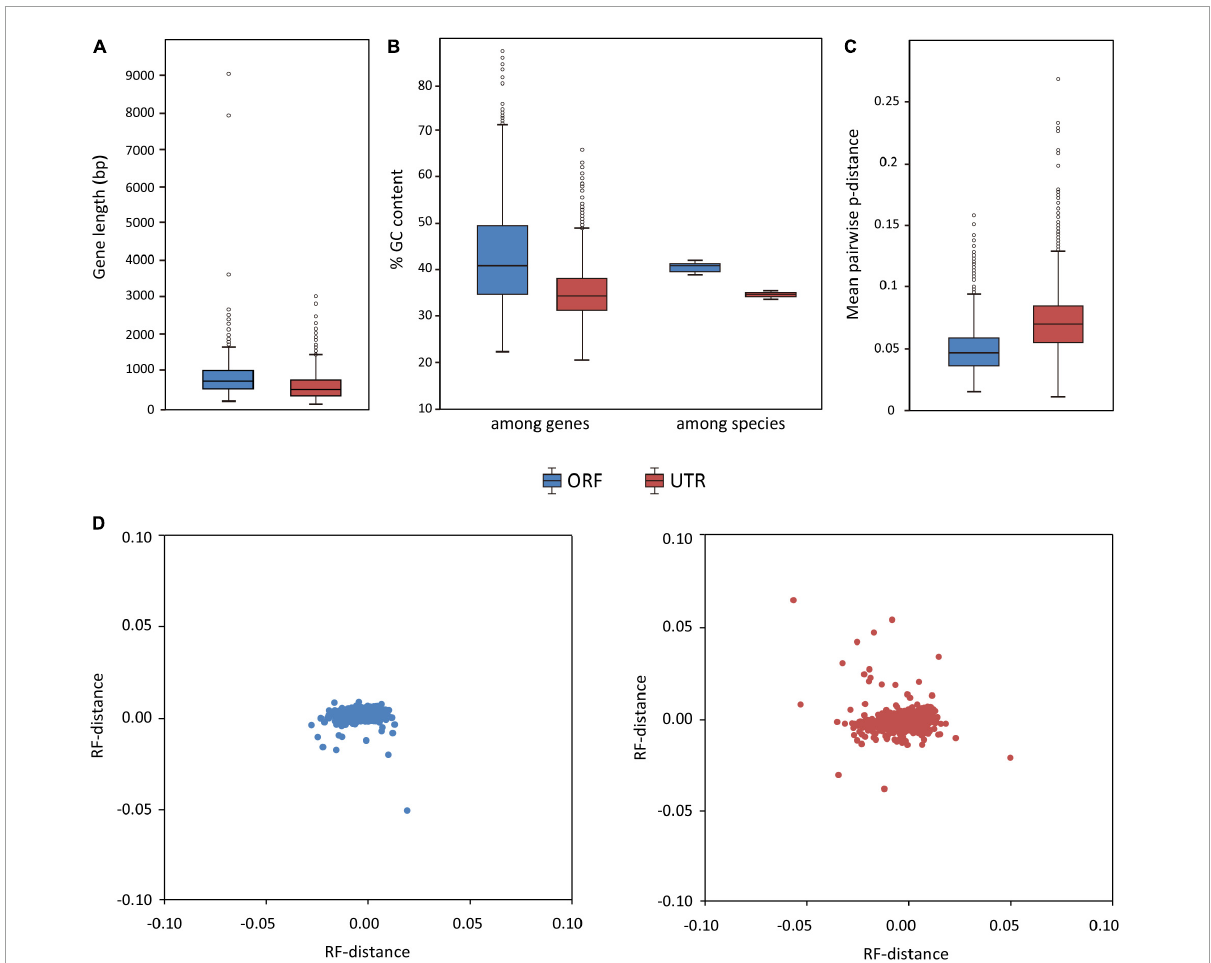
FIGURE5 Characteristics of the ORF and UTR data sets (blue = ORF, red = UTR). Boxplots show (A) distribution of locus length (bp), (B) distribution of GC content (among genes and among species), and (C) distribution of the evolutionary rates of the loci (measured by the mean pairwise distance of each locus). (D) Visualization of ML tree space using multidimensional scaling plot of 1,075 ORF gene trees (left) and 1,948 UTR gene trees (right); each dot represents a tree inferred from one gene. Distances between dots represent Robinson–Foulds distances between gene